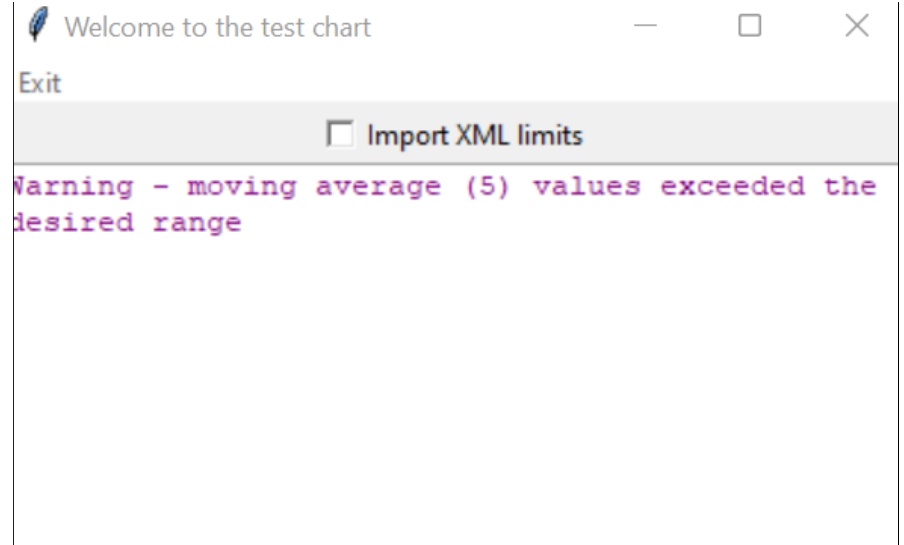
Figure 9. Warning generated by the monitoring graph (purple moving average